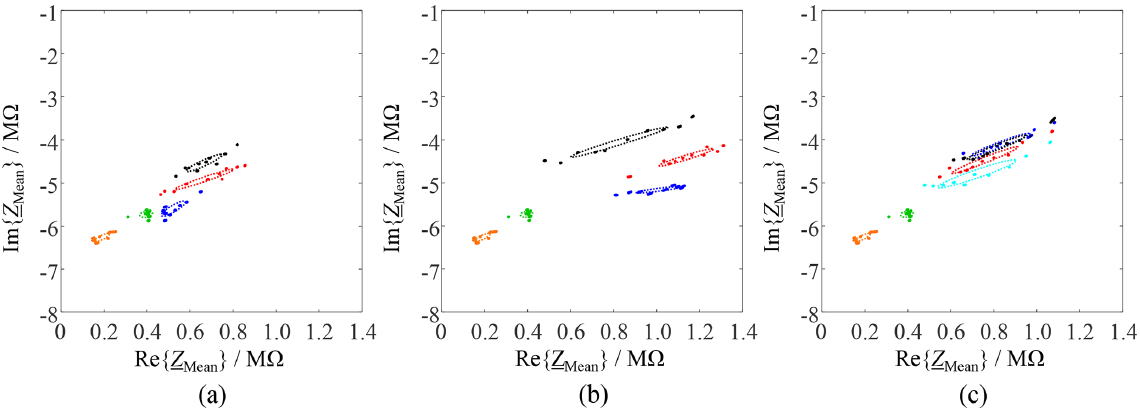
Figure 8. Distribution of the “mean” feature for repeated measurements of various MUTs. Color coding as in Fig. 6. (a) MUT 1a and b and MUT 2a to c. (b) MUT 1a and b and MUT 3a to c. (c) MUT 1a and b and MUT 4a to d.